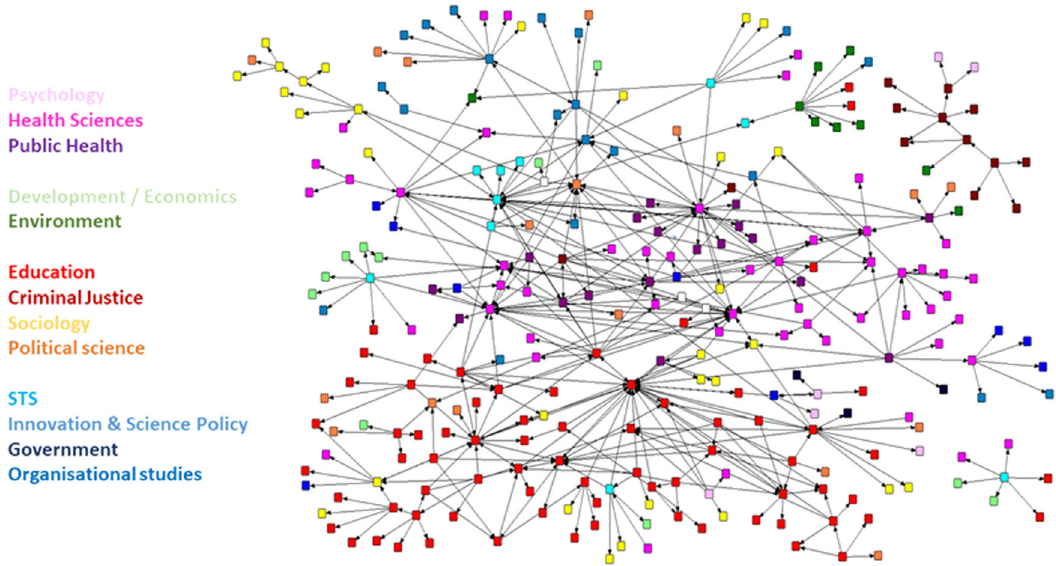
Fig. 5 Social network of the URE community. Respondents ’ nominations of in fl uential individuals are represented in a sociogram, and colored by fi elds of practice. Nominations are represented by directional